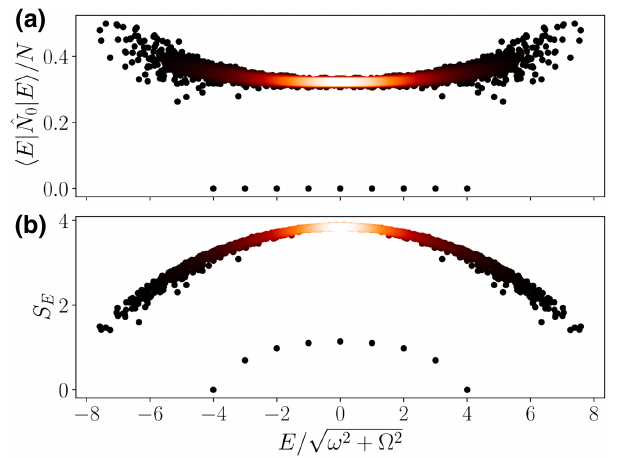
FIG. 3. (a) The expectation values of the observable ˆ N 0 and (b) the half-chain entanglement entropy S E clearly show the vio- lation of the ETH for the Dicke-scar states (the band of isolated states separated from the bulk, with low entropy and (cid:4) ˆ N 0 (cid:2) = 0). The color scale corresponds to the density of data points, with high-density regions in yellow and low-density regions in black. Parameters: N = 8, ω = 1.0, (cid:16) = 0.3, η = D = 0, φ = π/ 2, = c /( n − n (cid:10) ) 2 , where c λ n , n (cid:10) n , n (cid:10) n , n (cid:10) is chosen at random from the interval [0.5, 1.0], to break translation